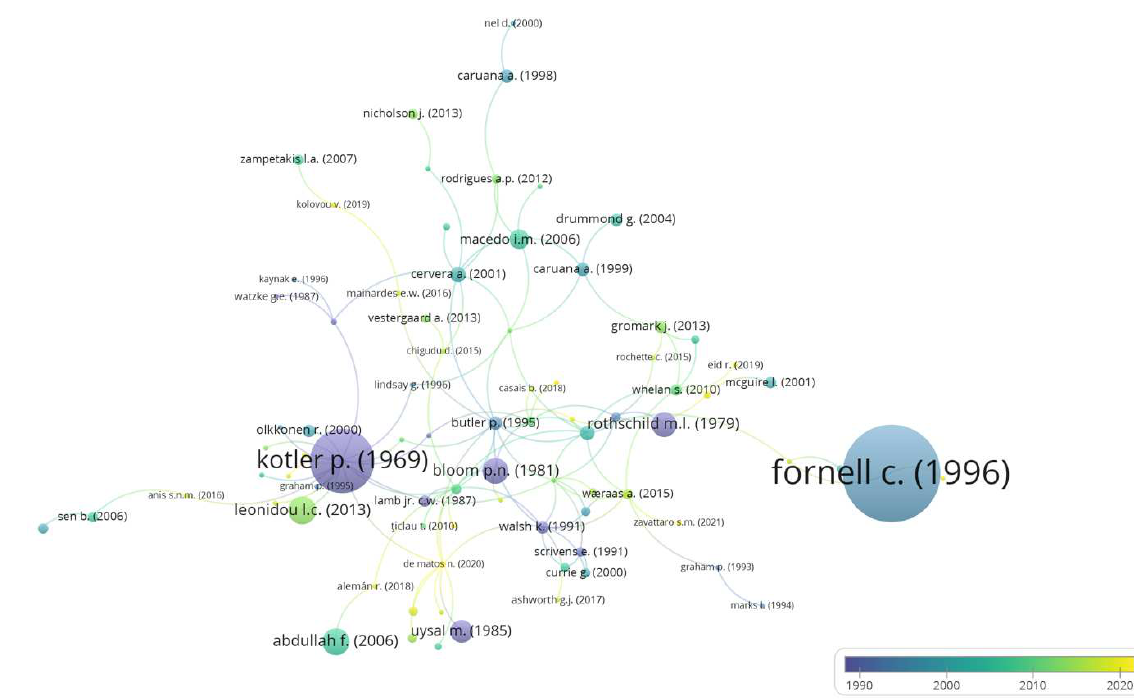
Figure 4. Overlay visualization map of spatio-temporal measurement of research on public